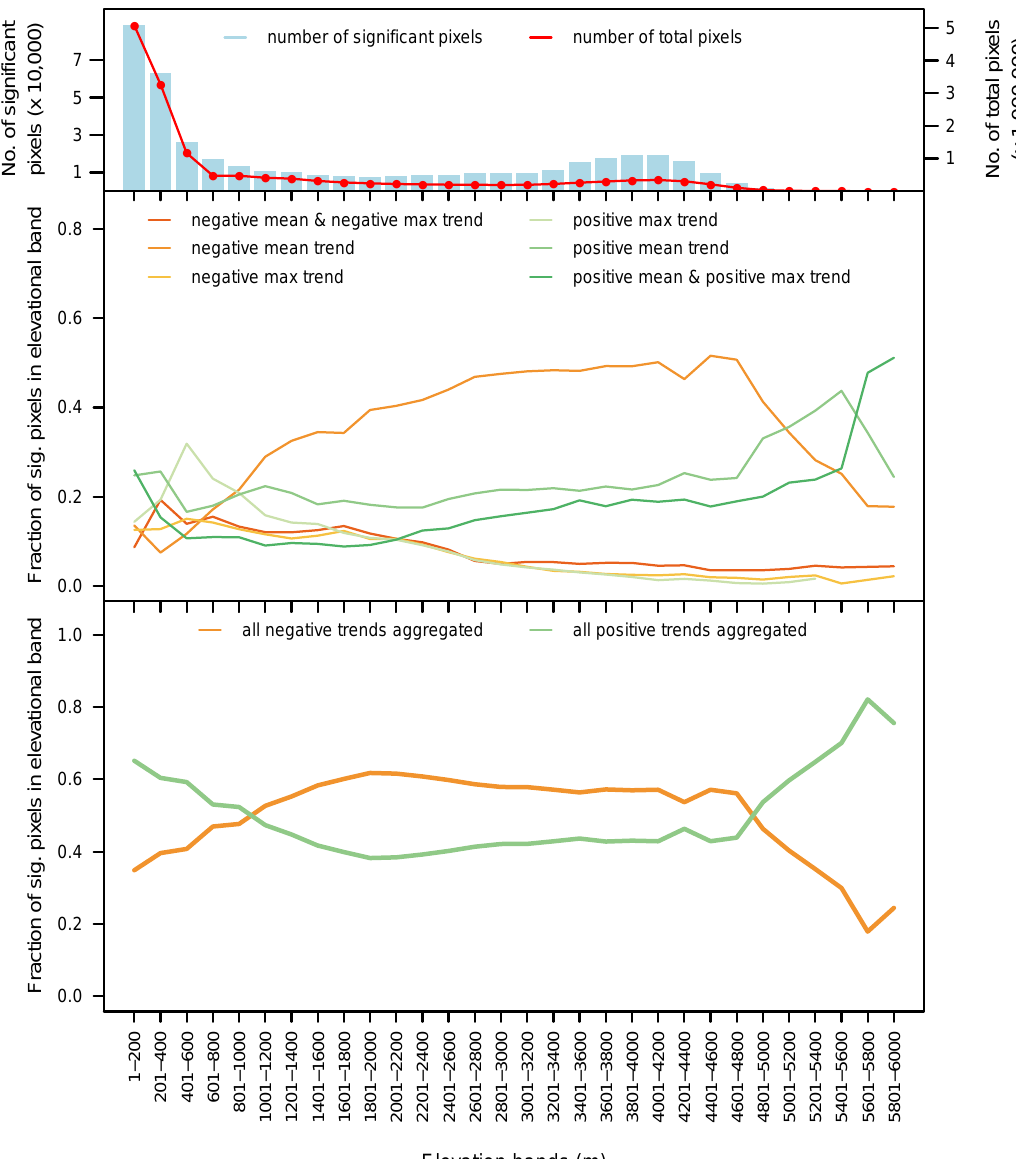
Figure 6. Greening and browning trends in the Amazon by elevation. The majority of greening, as measured by the number of significant pixels, was in the lowlands at elevations < 1000 m. Refer to the caption in Figure 5 for panel